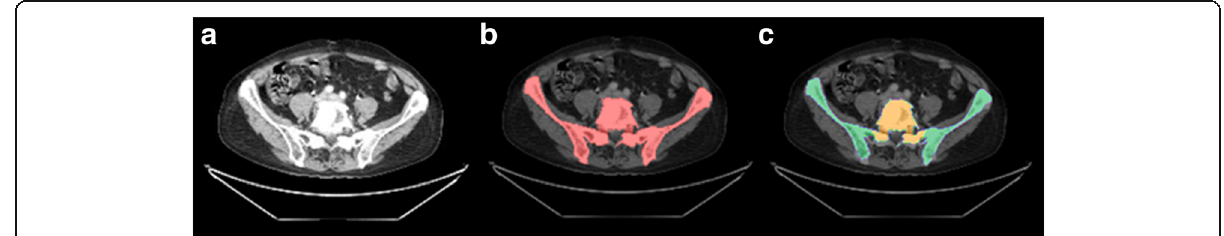
Fig. 1 Exemplary workflow for definition of skeletal compositions. a Exemplary patient CT. b Semi-automatic segmentation of patient-specific bone VOI. c Automatic definition of bone regions from non-rigidly co-registered